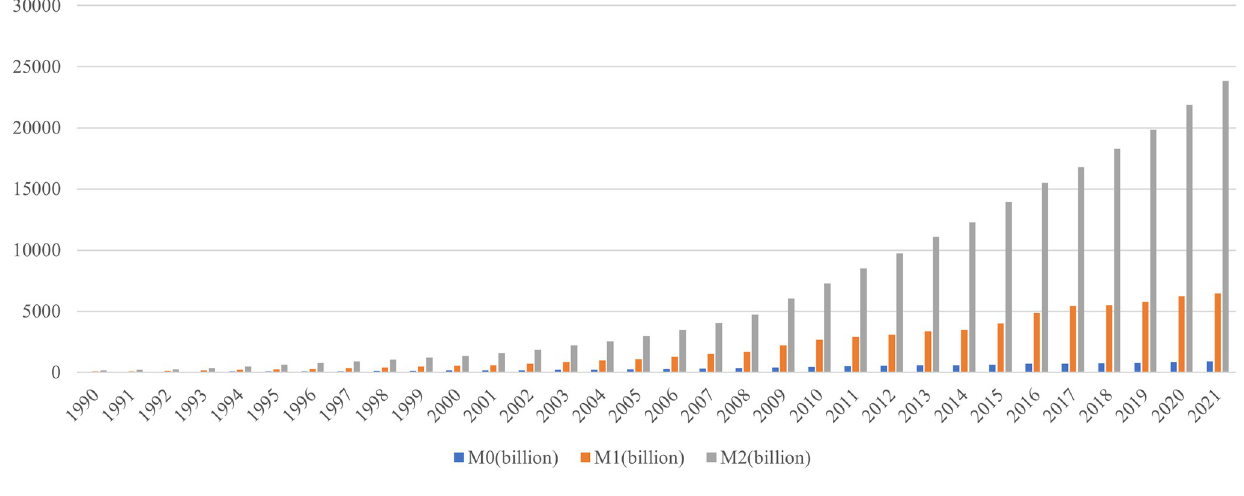
Fig 4. Total supply of M0, M1 and M2. Source: People’s Bank of